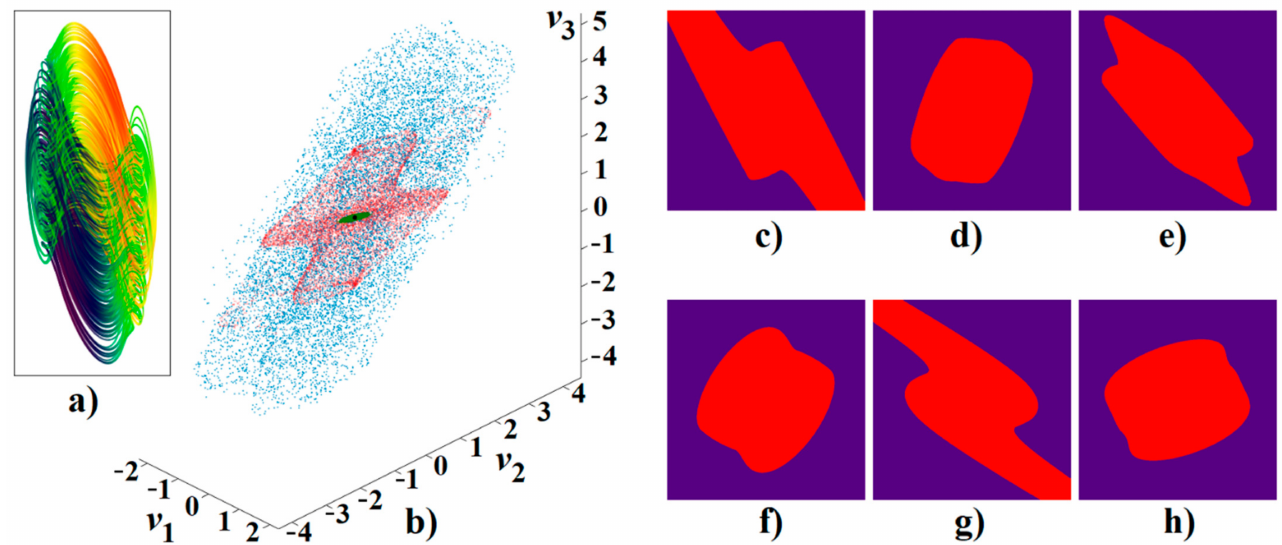
Figure 6. Clapp oscillator, Case II: ( a ) colored v 1 – v 2 – v 3 plane projection of a typical strange attractor and ( b ) sensitivity of system solution to tiny changes of initial states, visualization of the final states after short (green points), average (red points), and long (blue dots) time evolution. Basins of attraction visualized using plane fragments: ( c ) v 1 — v 2 , ( d ) v 1— v 3 , ( e ) v 1— i L , ( f ) v 2— v 3 , ( g ) v 2— i L , and ( h ) v 3— i L . Each subplot is calculated with uniform 0.01 step of the initial conditions (voltages or current) and with the rest of the initial conditions fixed on zero (voltages or current). See text for further